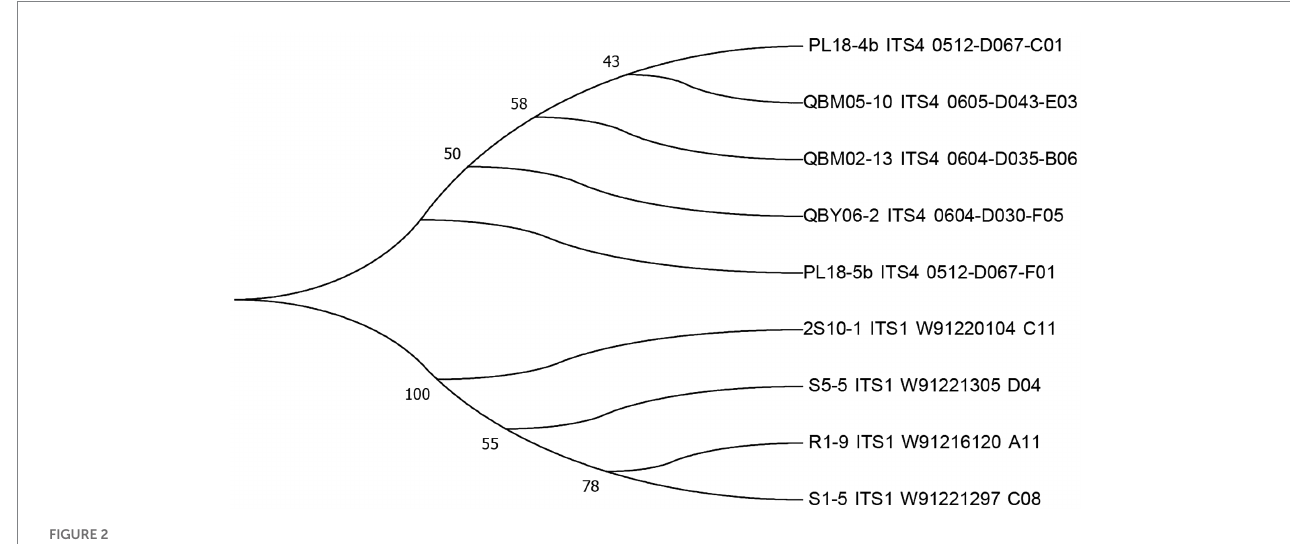
FIGURE 2 The phylogenetic trees of nine